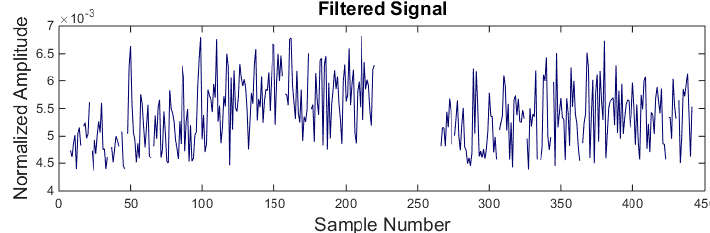
Figure 11. Signal filtration using back-propagation neural network.